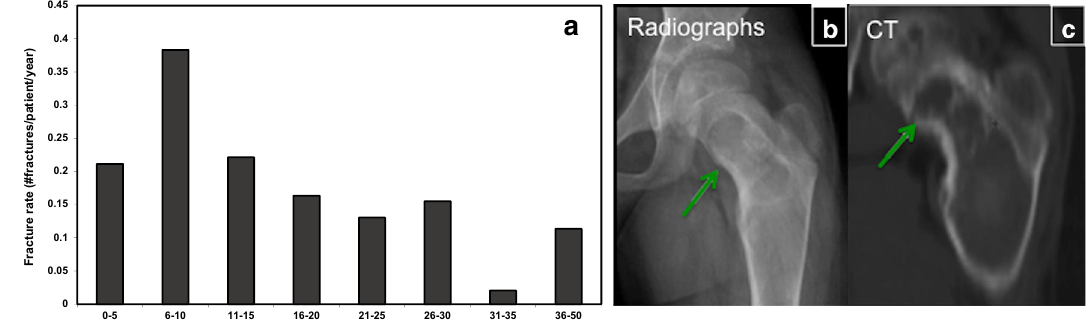
Fig.15 Fractures in fibrous dysplasia (FD). a Fractures are more frequent in childhood, with the highest rate occurring between 6 and 10 years of age. b , c Radiograph and CT of the left femoral bone demonstrate a